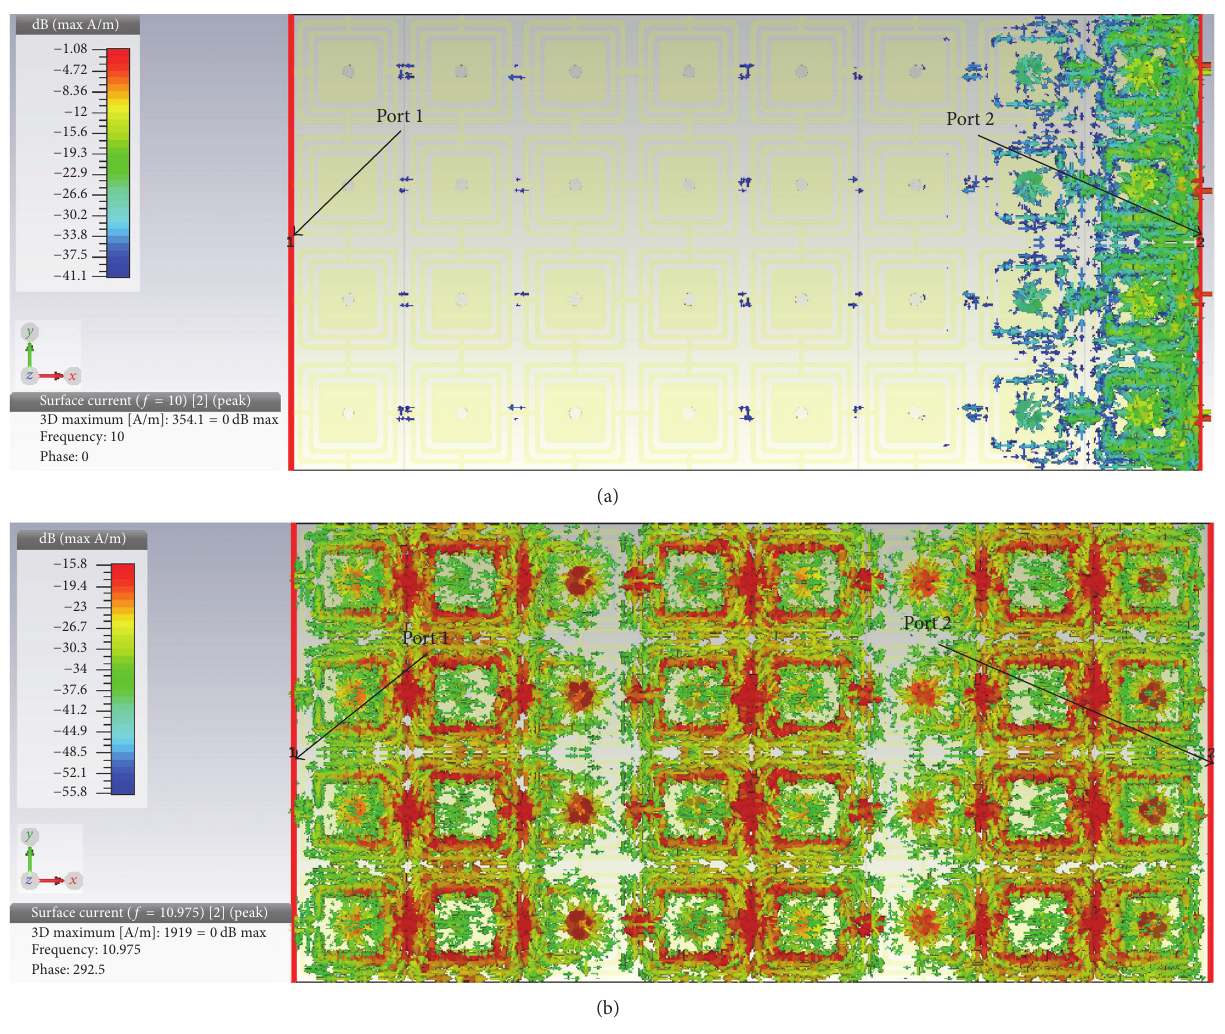
Figure 6: (a) Showing the simulated propagation of surface currents for 10GHz in the SNG region. (b) Showing the simulated propagation of surface currents for 9.975 GHz in the DNG (LHM)